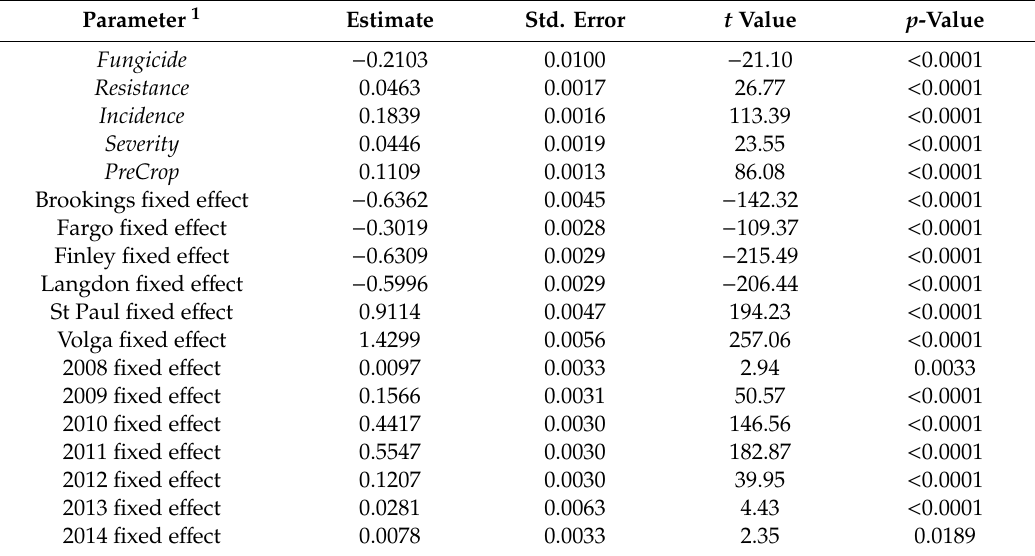
Table 3. Estimated slope coe ffi cients, location, and time fixed e ff ects, Equation